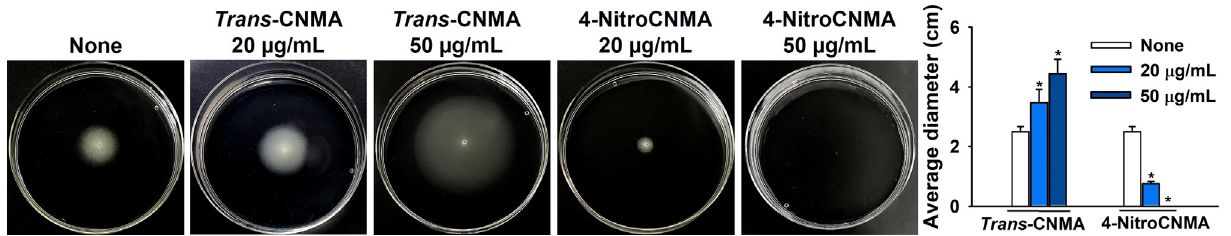
Figure 4. Swimming motility of UPEC in the presence of trans -CNMA or 4-nitroCNMA. Mean swimming motility was quantified using halo diameters. * p < 0.05 vs. nontreated controls (None).